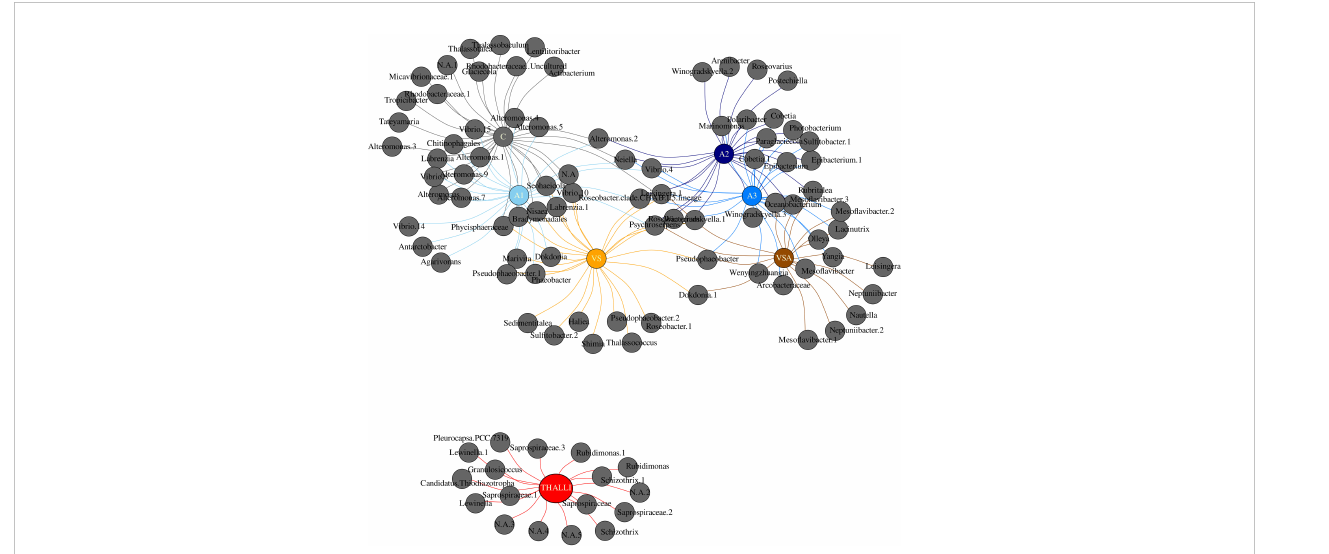
FIGURE 11 Indicator species analysis based on OTU > 1% abundance at the genus level of the adult thalli (red) and seedlings in each treatment. Treatments are color coded: C-gray, A1-baby blue, A2-blue, A3-navy blue, VS-orange,